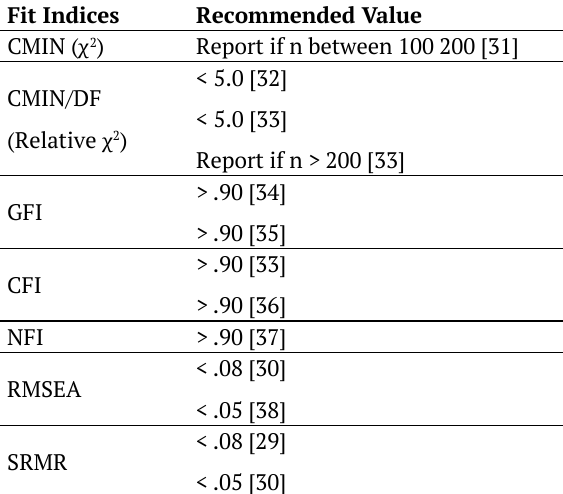
Table 1. The criteria for Fit